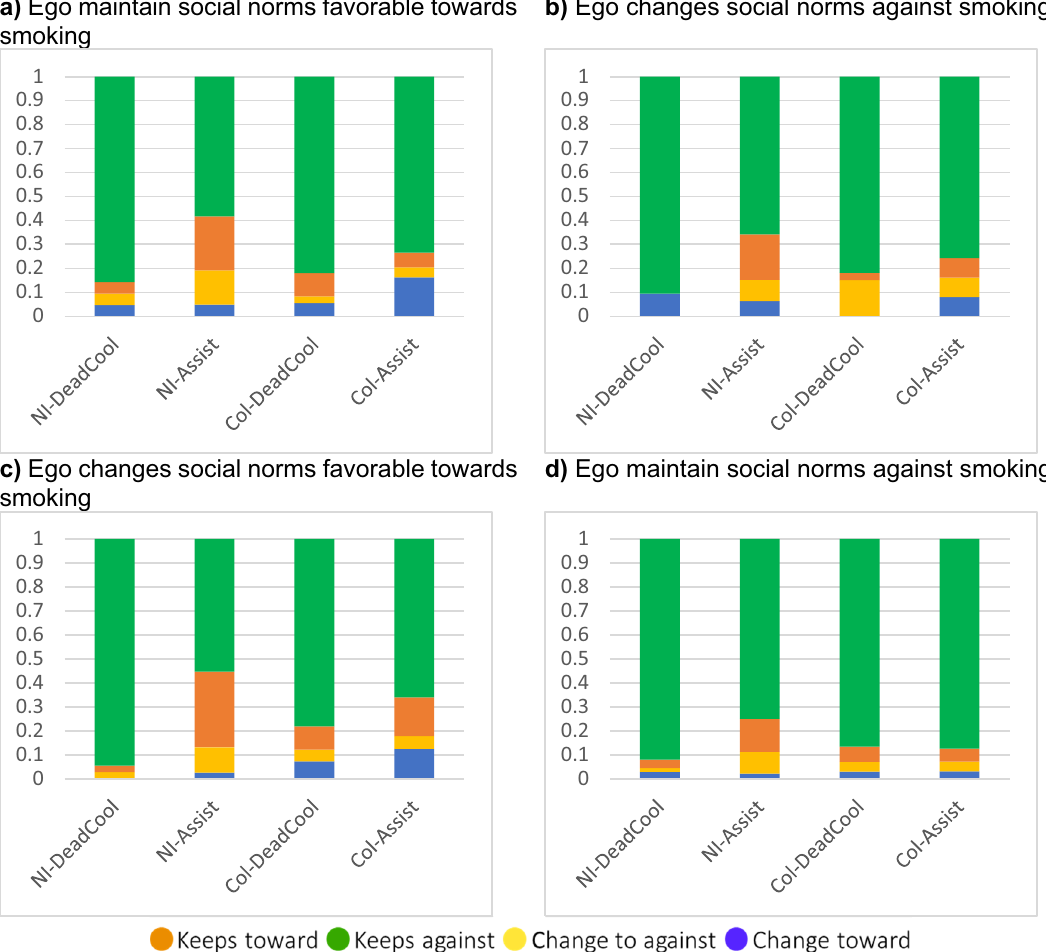
Figure 3. The proportion of friends that were maintained from baseline to follow-up by an ego (i.e. the individual participant) that changed their social norms, according to the change in the social norms of the ego. Each caption represents the proportion of ego’s friends that changed their social norms, differentiating by setting and intervention, according to the change of the ego’s social norms. Green represents students who maintained social norms against smoking, orange represents students who maintained social norms favorable towards smoking, yellow represents students who changed social norms to against smoking, and blue represents students who changed social norms to favorable towards smoking. For example, ( a ) shows the proportion of friends that changed or maintained their social norms for the egos that maintained their social norms favorable towards